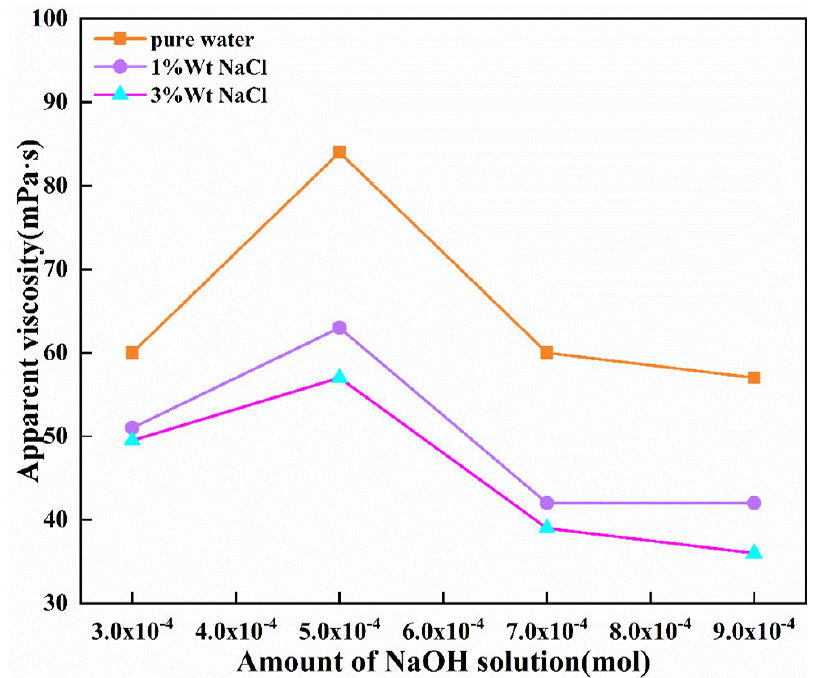
Figure 4. Influence of the amount of NaOH solution on the reaction.